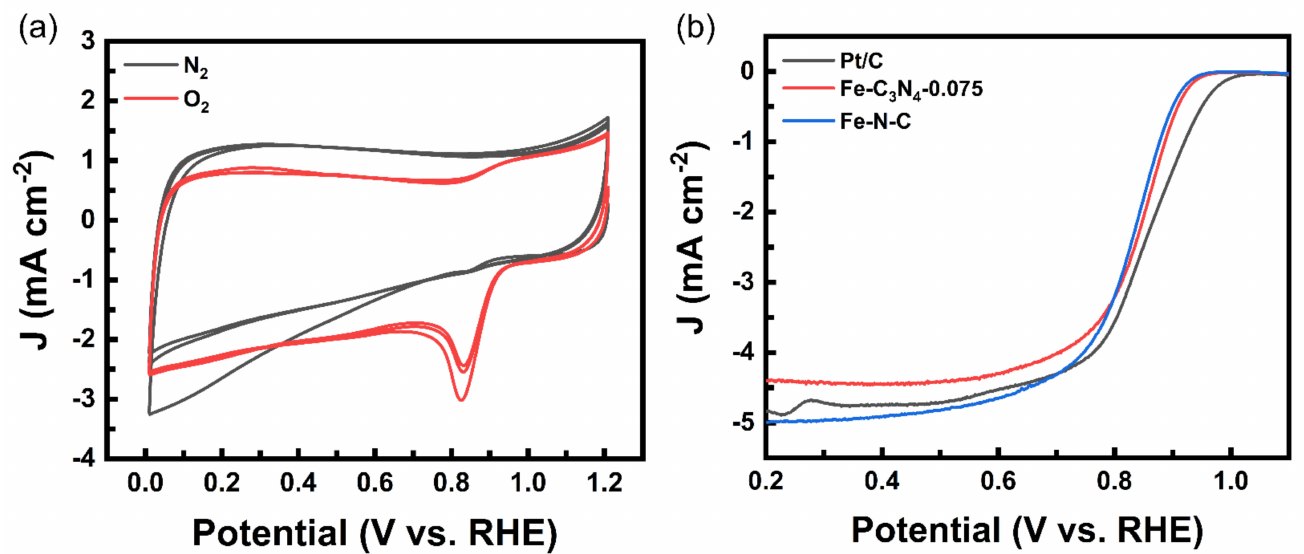
Figure 6. ( a ) CV curves of Fe-C 3 N 4 -0.075 in O 2 -saturated 0.1 M KOH with a sweep rate of 50 mV/s. ( b ) ORR polarization plots of Fe-C 3 N 4 -0.075 and Pt/C in O 2 -saturated 0.1 M KOH with a sweep rate of 5 mV/s and 1600